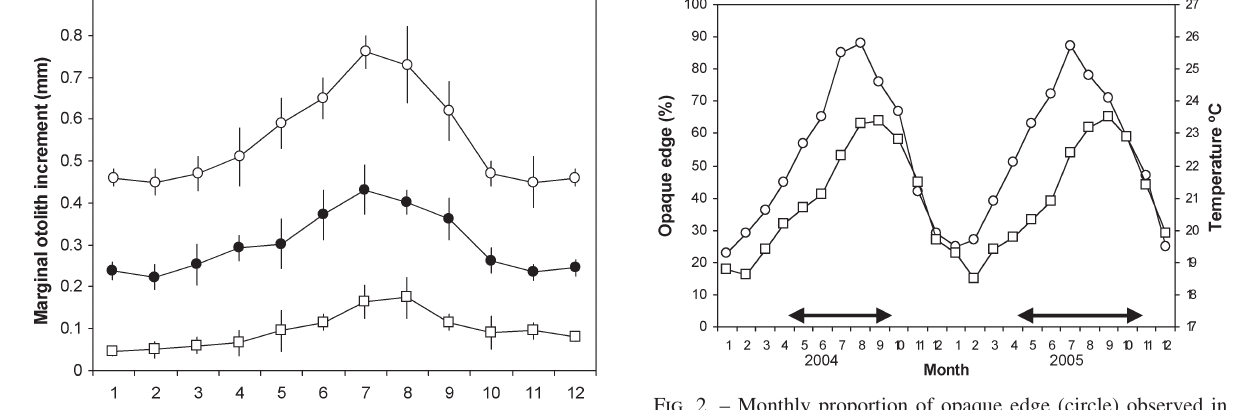
Fig. 2. – Monthly proportion of opaque edge (circle) observed in whole otoliths of Mycteroperca fusca off the canary Islands, and Fig. 1. – Mean monthly width of the marginal increment from otoliths of Mycteroperca fusca for specimens of 2-4 years (circle; n=50), 5-7 years (solid circle; n=63), and 7-10 years (squares; n=33) off the canary Islands. each error bar represents the standard devia- tion. age 11+ fish were not used.